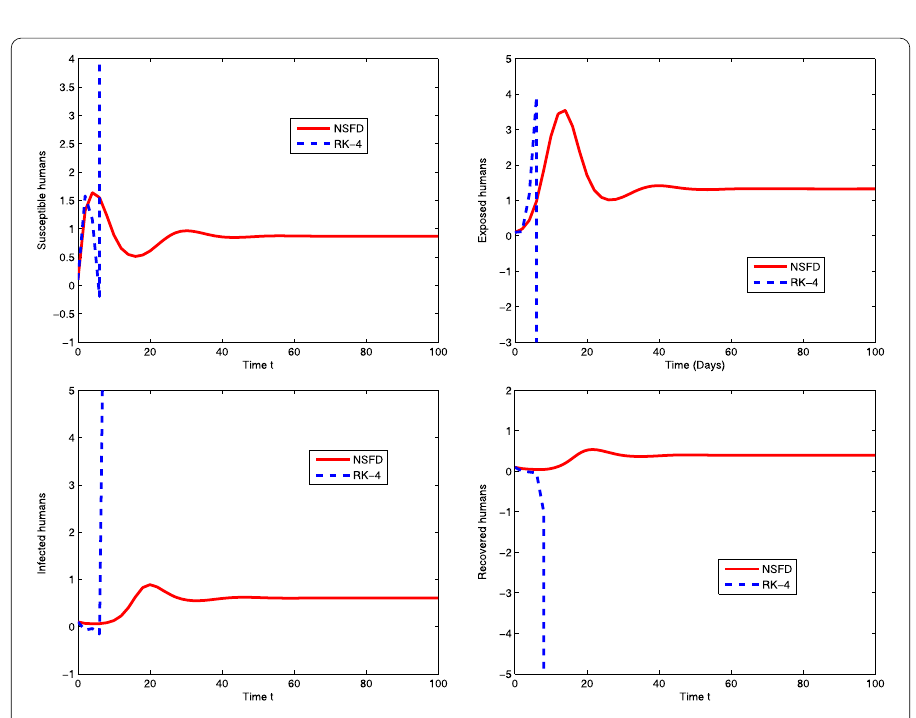
Figure 7 Comparison of solutions obtained by NSFD and RK4 numerical schemes for F 1 with an initial condition ( S (0), E (0), I (0), R (0)) = (0.1,0.1,0.1,0.1) and step size h = 2.0 with R 0 = 7.0735 > 1. The comparison shows that the RK4 scheme fails to converge, whereas the NSFD scheme improves the result obtained by RK4 and it is seen to be convergent dynamically to the correct endemic equilibrium F